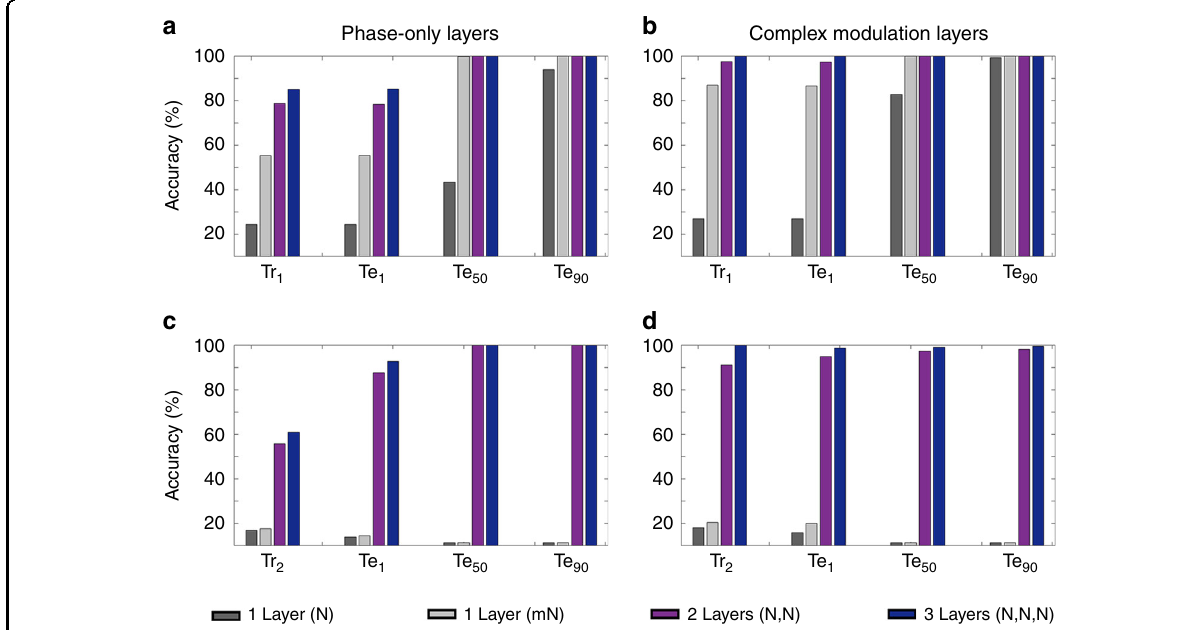
Fig. 4 Training and testing accuracy results for the diffractive surfaces that perform image classi fi cation (Fig. 3). a The training and testing classi fi cation accuracies achieved by optical network designs composed of diffractive surfaces that control only the phase of the incoming waves; the training image set is Tr 1 (200K images). b The training and testing classi fi cation accuracies achieved by optical network designs composed of diffractive surfaces that can control both the phase and amplitude of the incoming waves; the training image set is Tr 1 . c , d Same as in a , b , respectively, except that the training image set is Tr 2 (6.4K images). N = 40K neurons, and mN = 122.5K neurons, i.e., m >